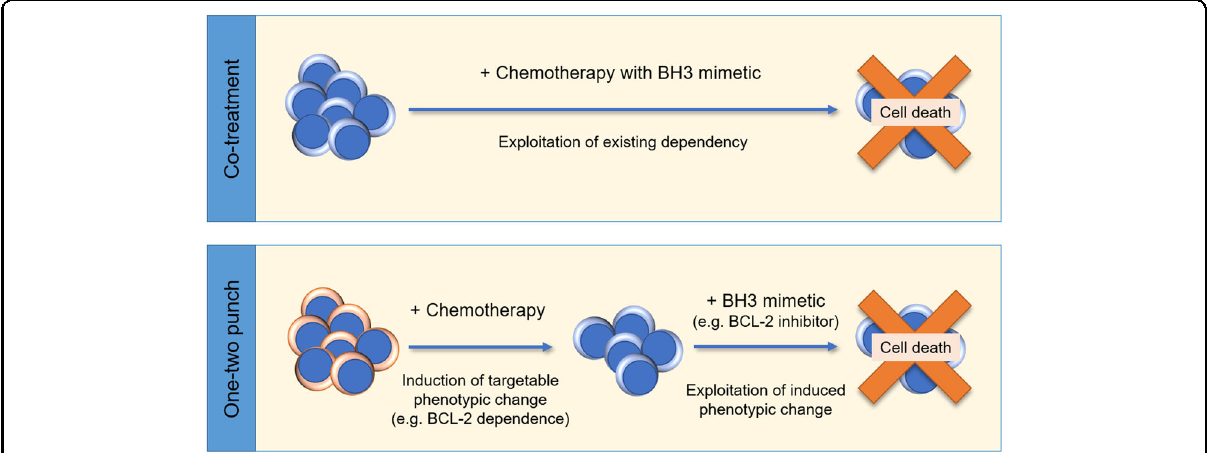
Fig. 4 Differing treatment methods deserve consideration for the application of BH3 mimetics in combination with standard therapies. Proposed methods for combination treatments with BH3 mimetics include co-treatment with a chemotherapy or inducing an increase in dependency on a BCL-2 prosurvival protein by treatment with chemotherapy which can then be targeted with a BH3 mimetic (one-two punch